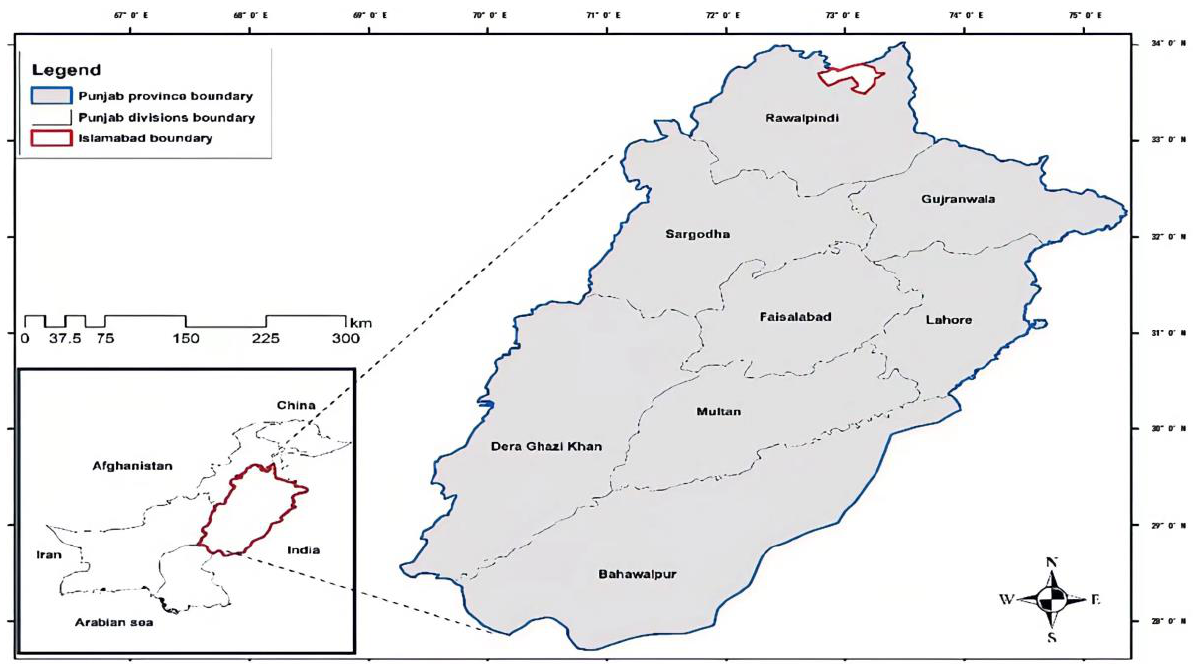
Figure 1. Sample collection